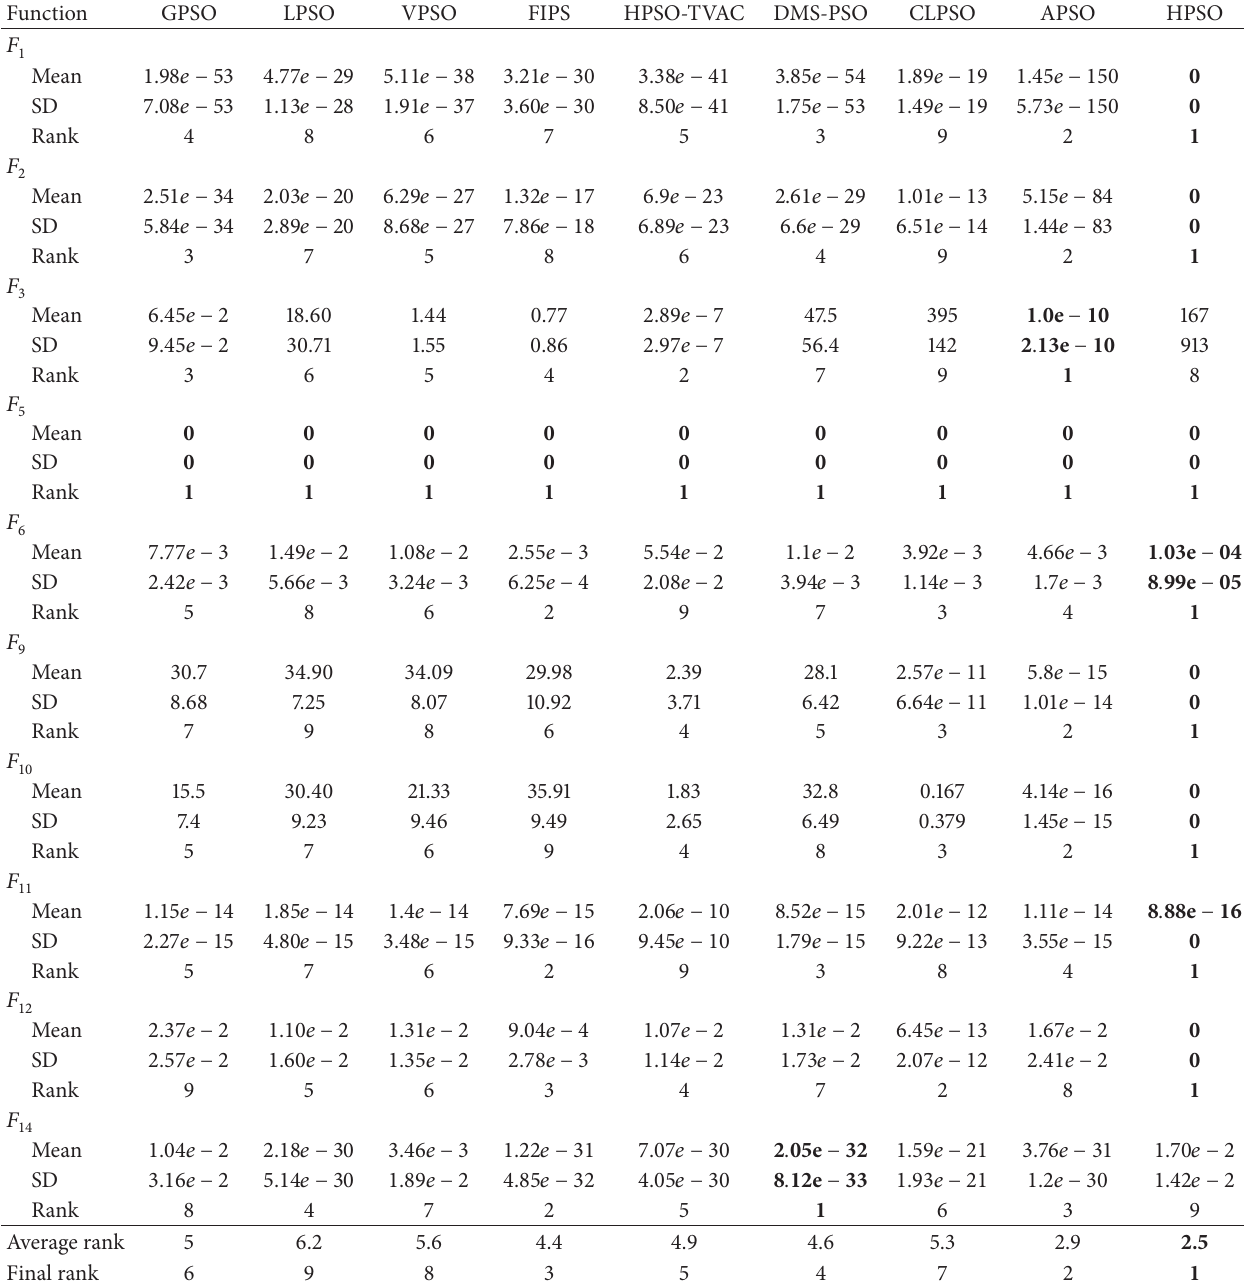
Table 6: Comparison results of eight PSO algorithms [22] with HPSO on 10 functions ( 𝑁 = 20 , 𝐷 = 30 , and FEs = 2 × 10 5 ).